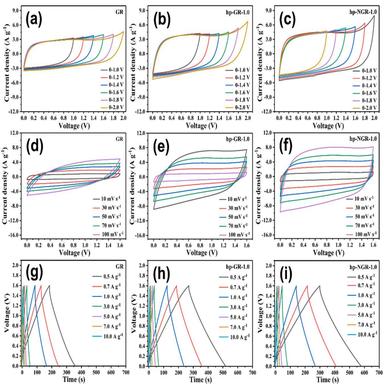
CV curves within various voltage windows (at 50 mV s−1) (a-c), CV curves at various scan rates (d-f) and GCD curves at different current densities (g-i) of the GR, hp-GR-1.0 and hp-NGR-1.0 based symmetrical devices.